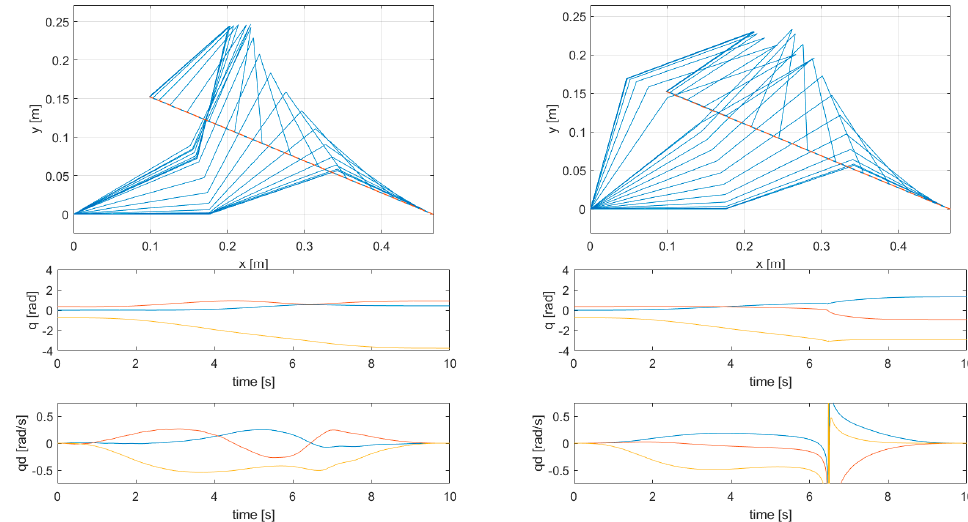
Figure 6. Trajectory 3, comparison between PMKE ( left ) and LSV ( right ). First joint: blue lines; second joint: red lines; third joint: yellow lines. Joint velocities at the singularity not shown in LSV.